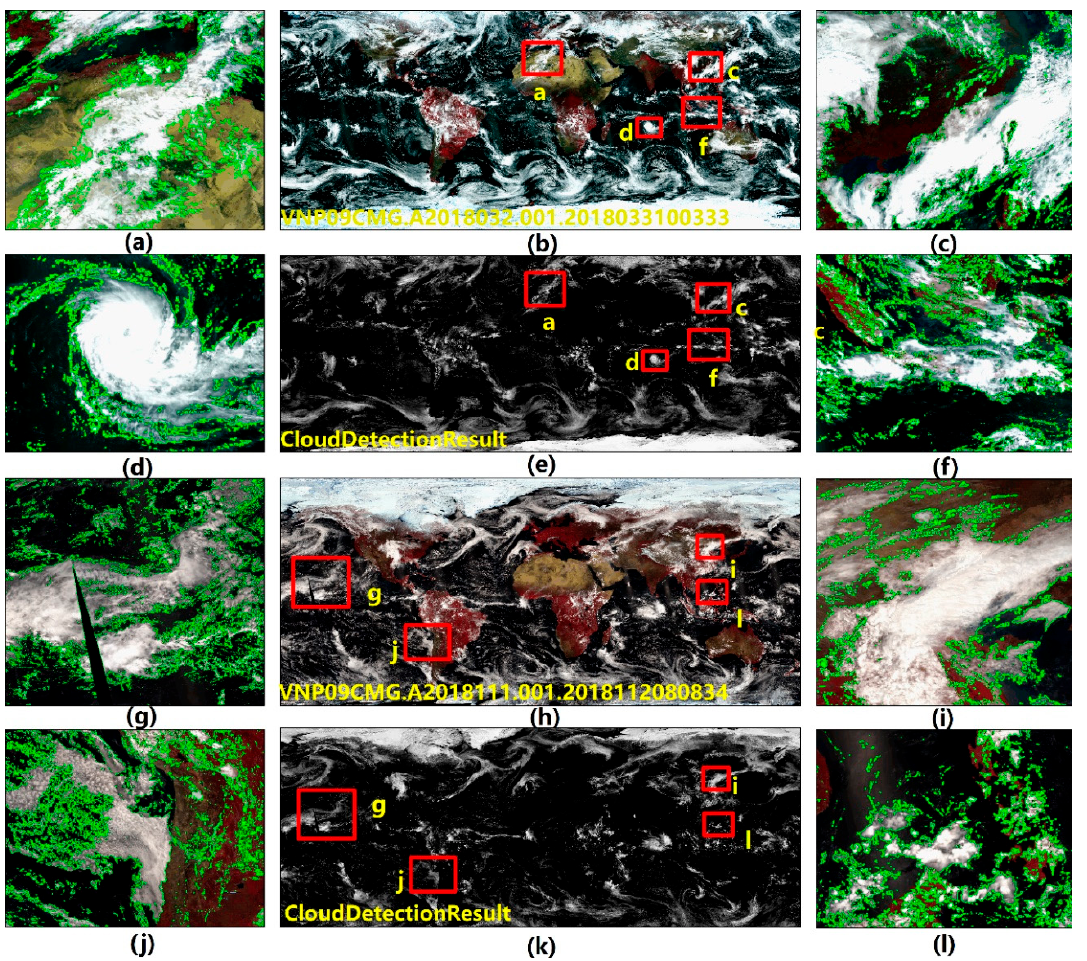
Figure 12. The original map ( b , h ) and the cloud detection results ( e , k ) obtained using the EN-Clustering method, for two selected VIIRS images. ( a ) Cloud detection results for thick clouds over the Sahara Desert; ( d ) Cloud detection results for cyclone over the Indian Ocean region; ( c , f ) thick clouds and broken clouds over the coastal area of the SCS; ( g ) Thin cloud detection results over the Atlantic Ocean; ( j ) Thin cloud and broken cloud detection results over the coastal area; ( l ) Thick cloud and broken cloud detection results over the coastal area of the SCS; and ( i ) Cloud detection results for thick and thin clouds over Northeast Asia region.